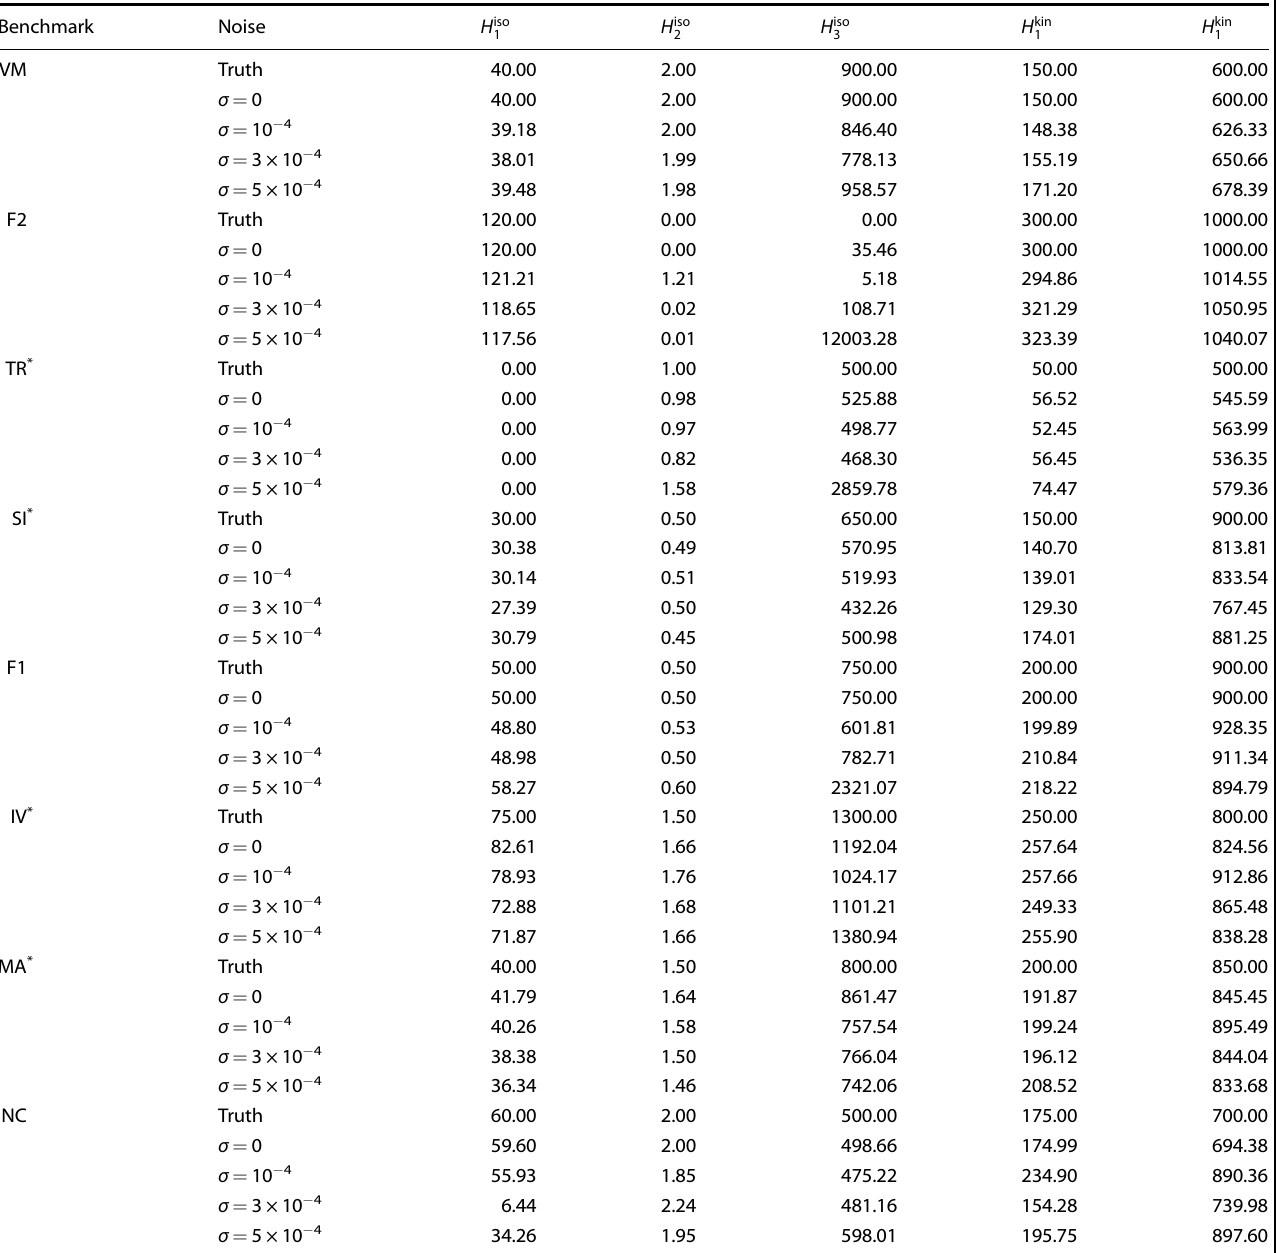
Table 2. Hardening parameters of the (true) hidden and discovered plasticity models ( σ in mm).